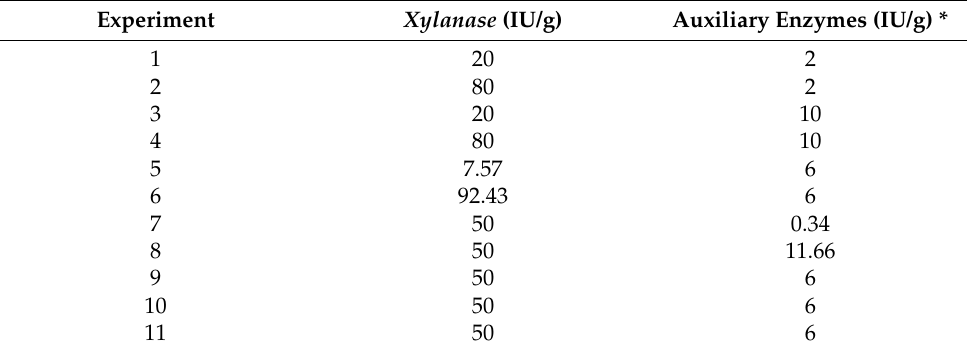
Table 5. Experimental design for xylooligosaccharides